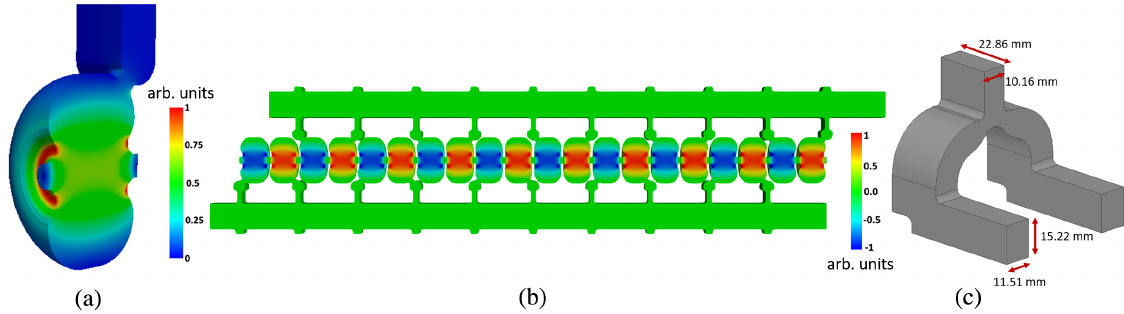
FIG. 6. (a) The cell-design shape with the feeding port and electric field profile plot. (b) The full design and electric field profile of 20 cells π -mode distributed-coupling linac with identical cells at X-band. (c) The power divider designed to distribute the power equally between the two feeding manifolds from a WR90 feeding port.